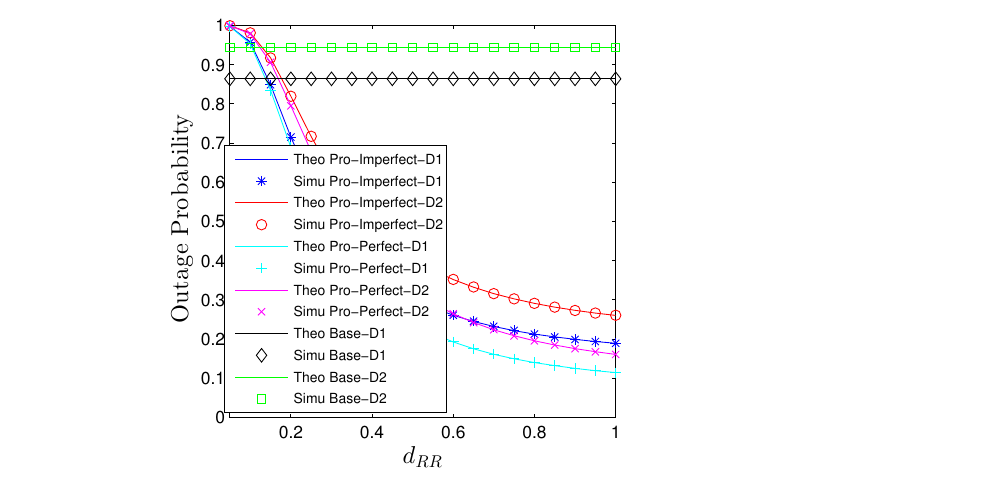
Figure 6. Outage probability vs. d m , m under all schemes. Solid lines are plotted by employing (15)–(17) while markers are Monte Carlo simulation.